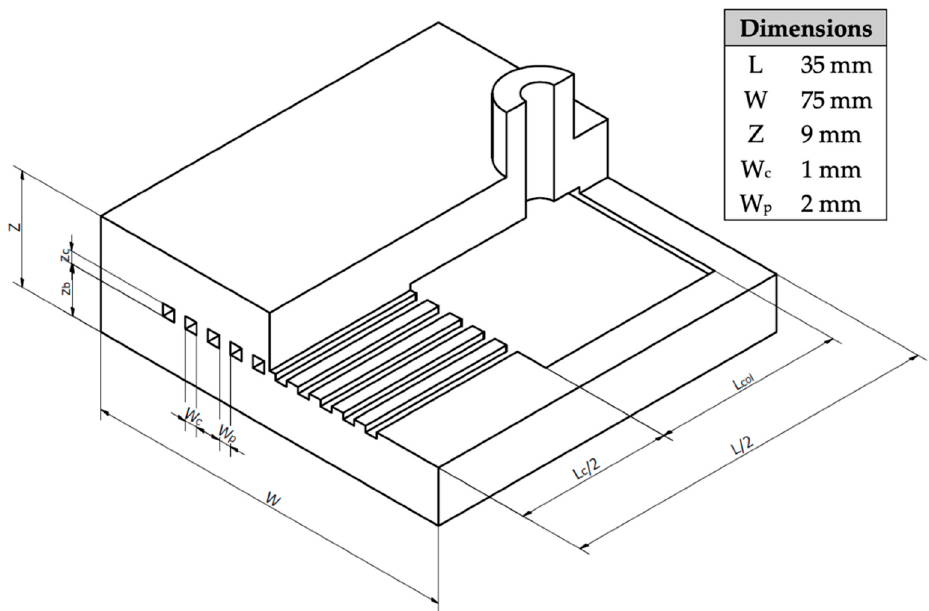
Figure 1. Schematic representation of the acrylonitrile–butadiene–styrene (ABS) master mold and respective dimensions (heat sink length, L; width, W; height, Z).